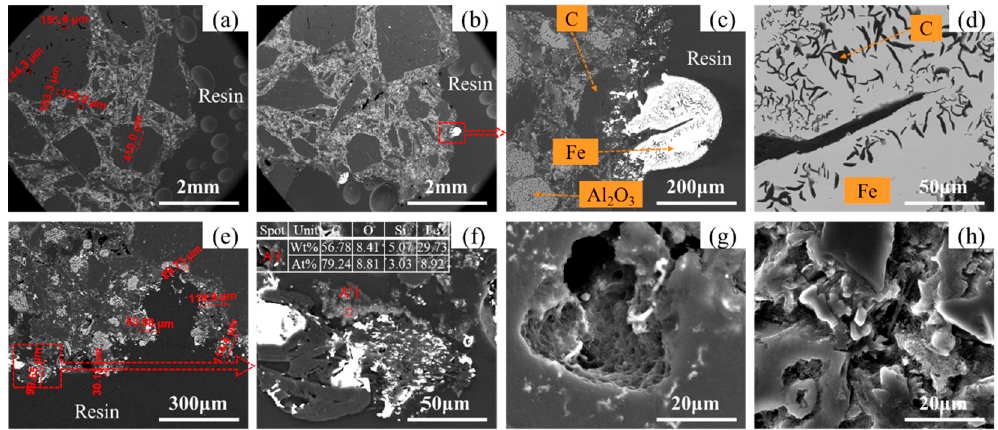
Figure 11. ( a – h ) Microscopic morphology of A after corrosion.